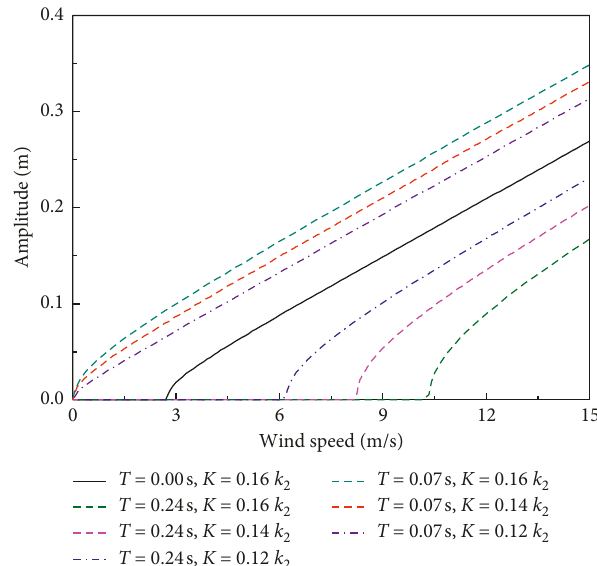
Figure 4: Variation of galloping amplitude of m parameter T under different strength parameter K .